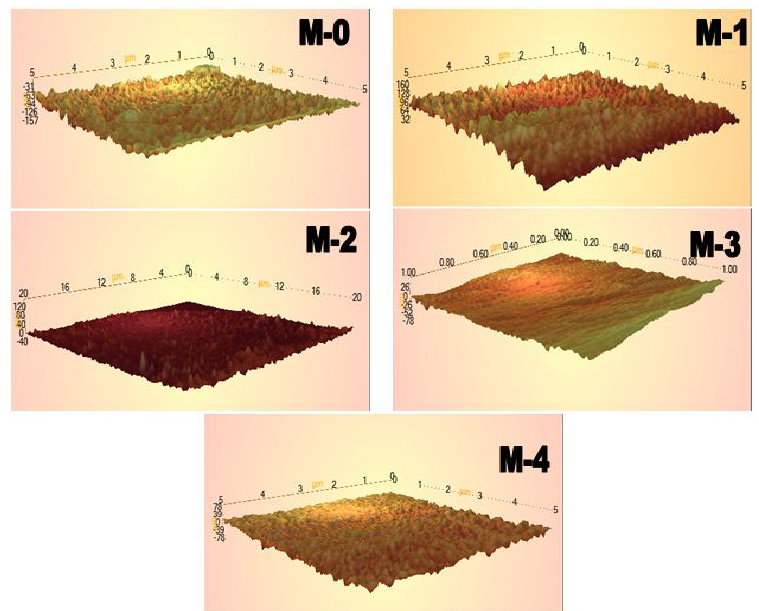
Figure 7. 3D AFM images of the upper nanocomposite membranes PSF and PSF/ZnO